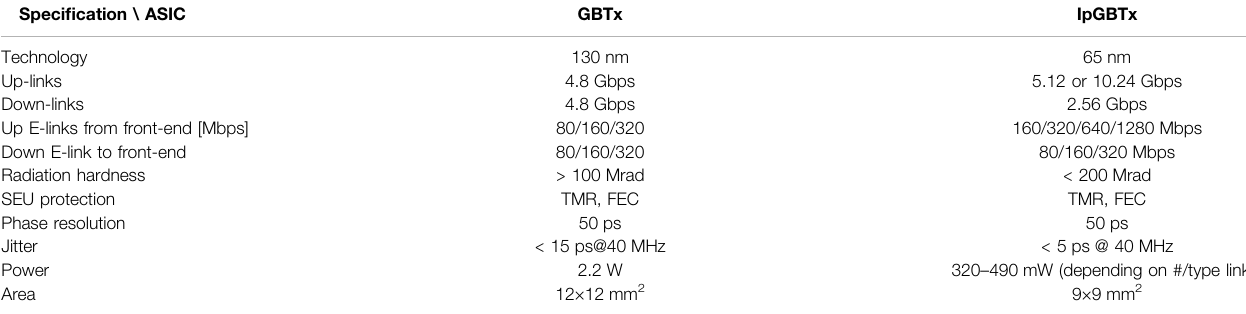
TABLE 3 | Evolution of GBT to lpGBT, a comparison table of the essential speci fi cations. Speci fi cation \ ASIC GBTx